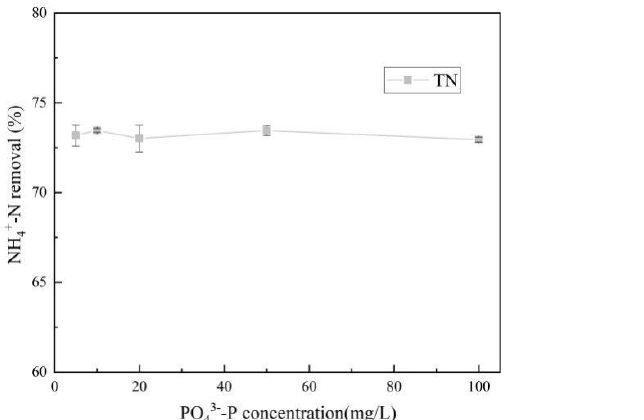
Figure 9. XRD patterns of adsorbed sediments at different pH values.